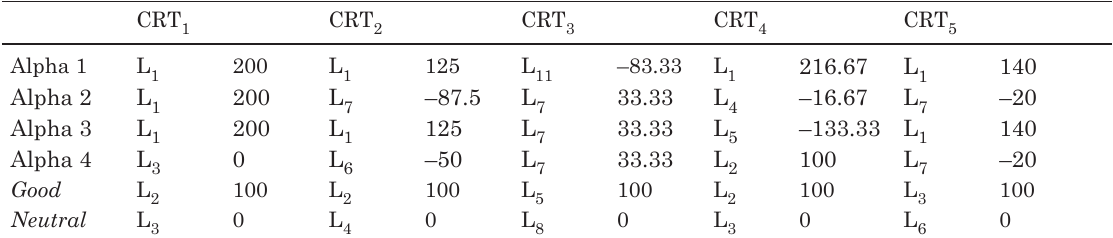
Table 2. levels and Values of partial attractiveness revealed by the evaluated